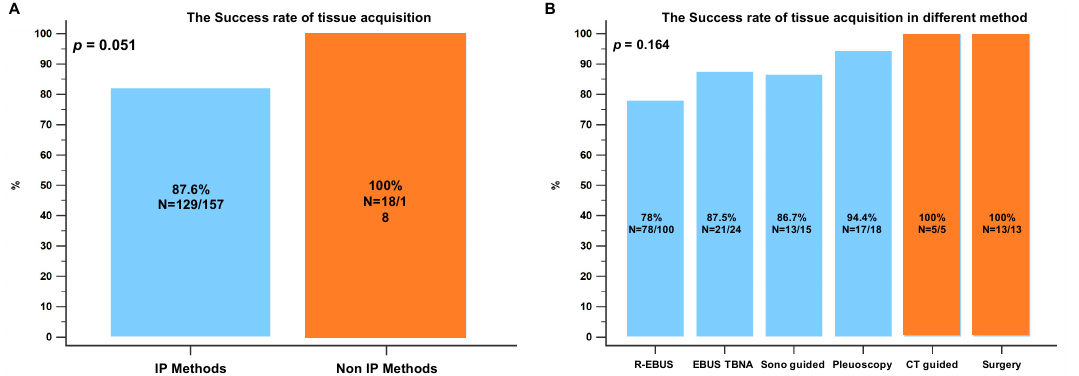
Figure 4. ( A ) The tissue acquisition success rates of all IP and all non-IP methods. ( B ) The tissue acquisition success rates of different IP and non-IP biopsy methods. CT: computed tomography; IP: interventional pulmonology; R-EBUS: radial probe endobronchial ultrasound; TBNA: transbronchial needle aspiration.